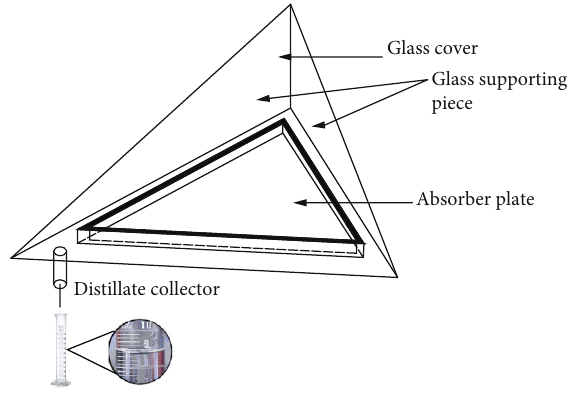
Figure 1: Graphical representation of